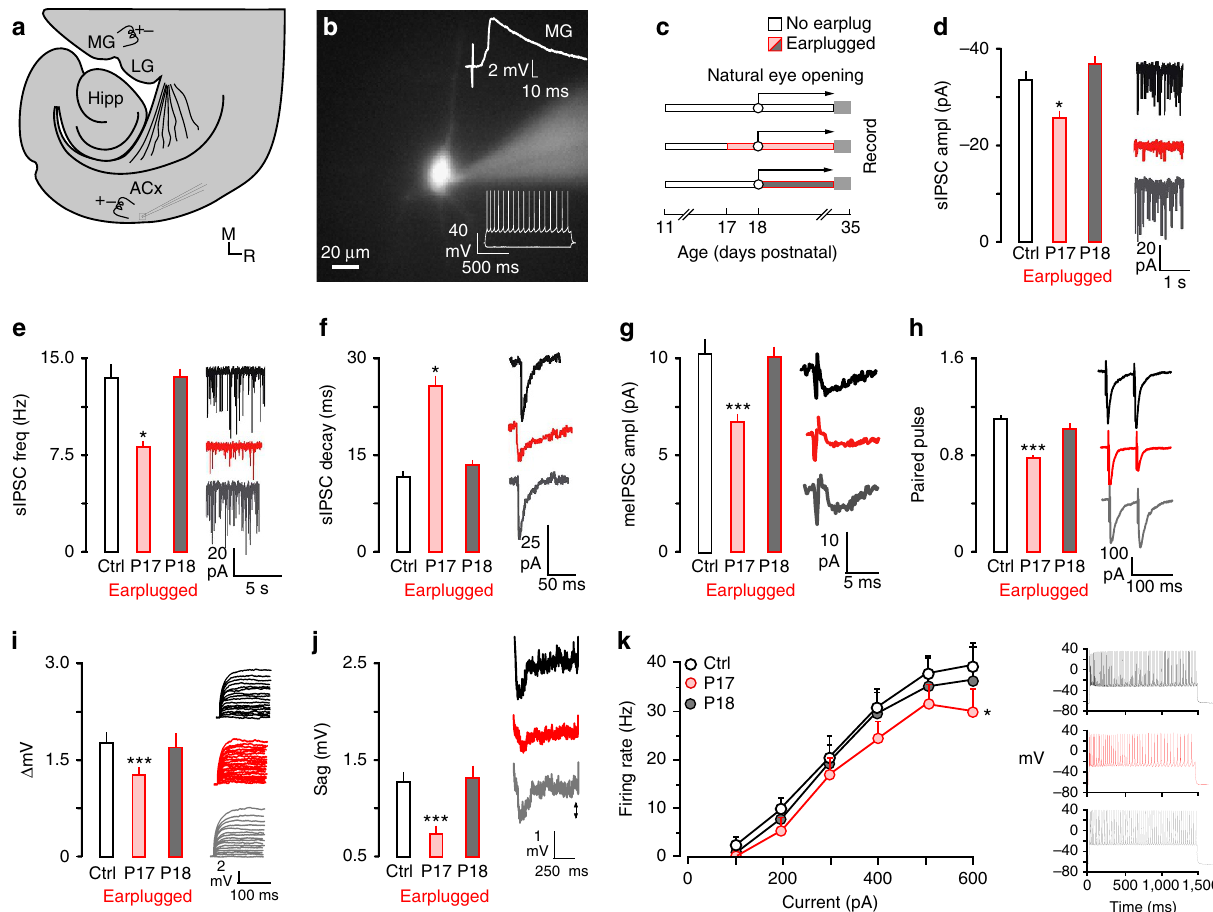
Figure 1 | Natural eyelid opening closes the ACx CPs of sensitivity to hearing loss. ( a ) Diagram illustrates the thalamocortical brain slice preparation (ACx, auditory cortex; Hipp, hippocampus; LG, lateral geniculate; MG, medial geniculate;). The approximate position of the recording electrode in ACx